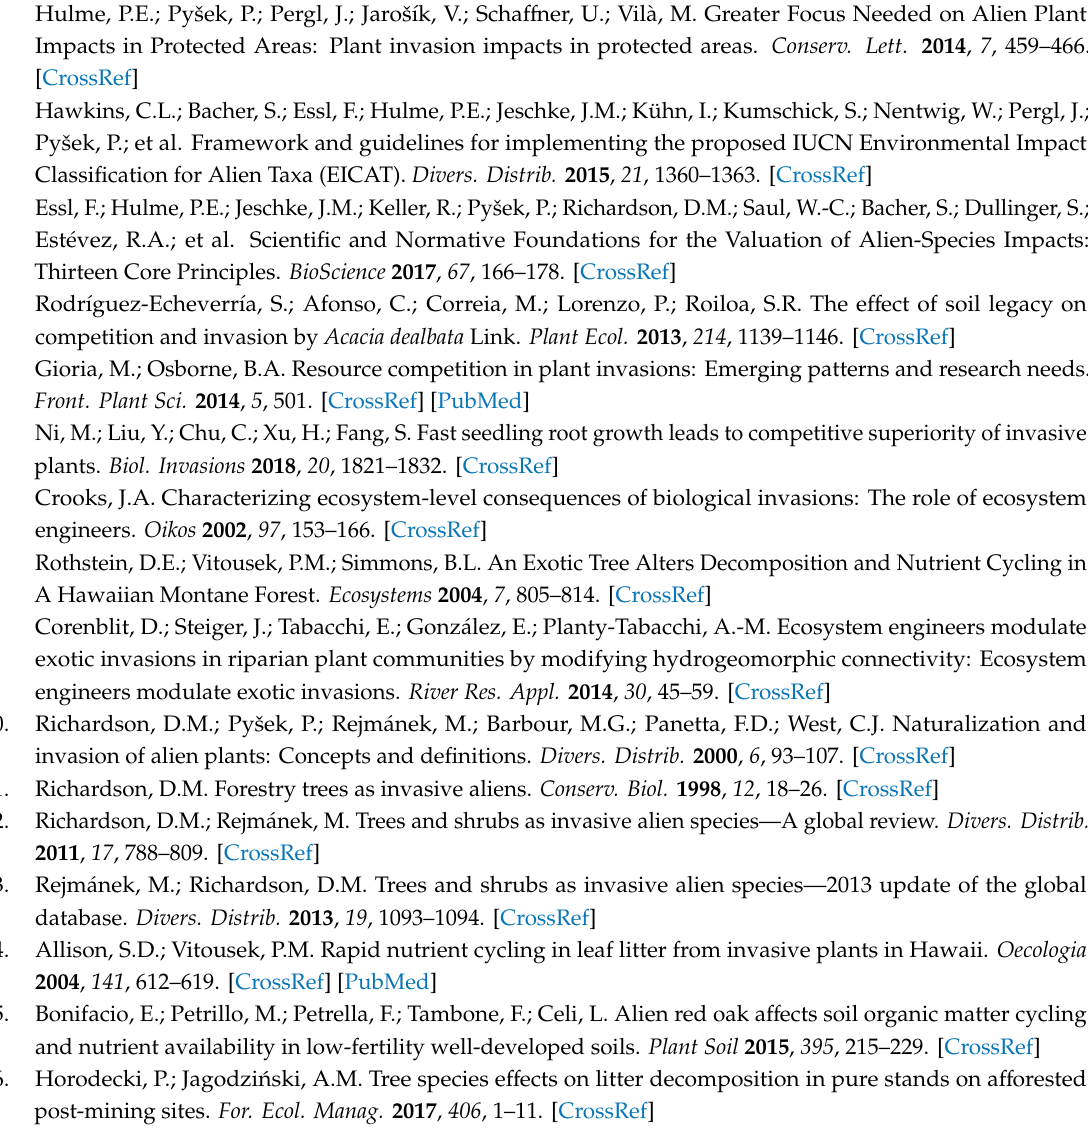
Table S1: List of species present in study plots, allometric models used for foliage biomass estimation (Table S3), and alien status; Table S2: Mean + SE values of SLA obtained from databases for species present in study plots; Table S3: Allometric equations determining foliage biomass of particular tree species recorded on the study